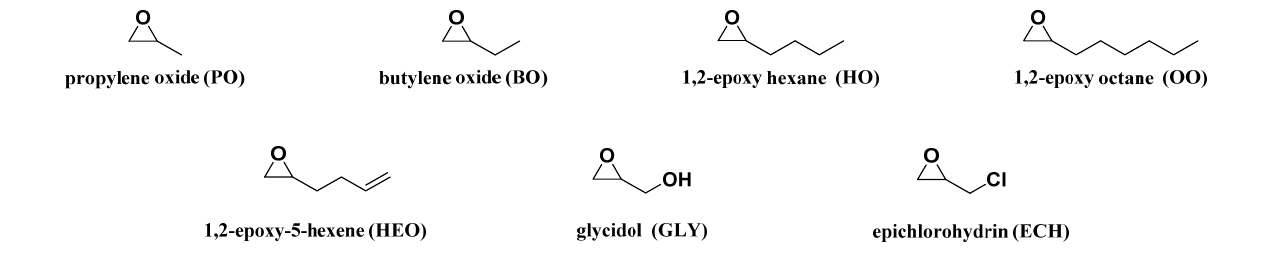
Figure 2. Oxiranes selected to study their influence in the LPBs microstructure. Table 5. Influence of the oxirane nature on the LBP microstructure a .